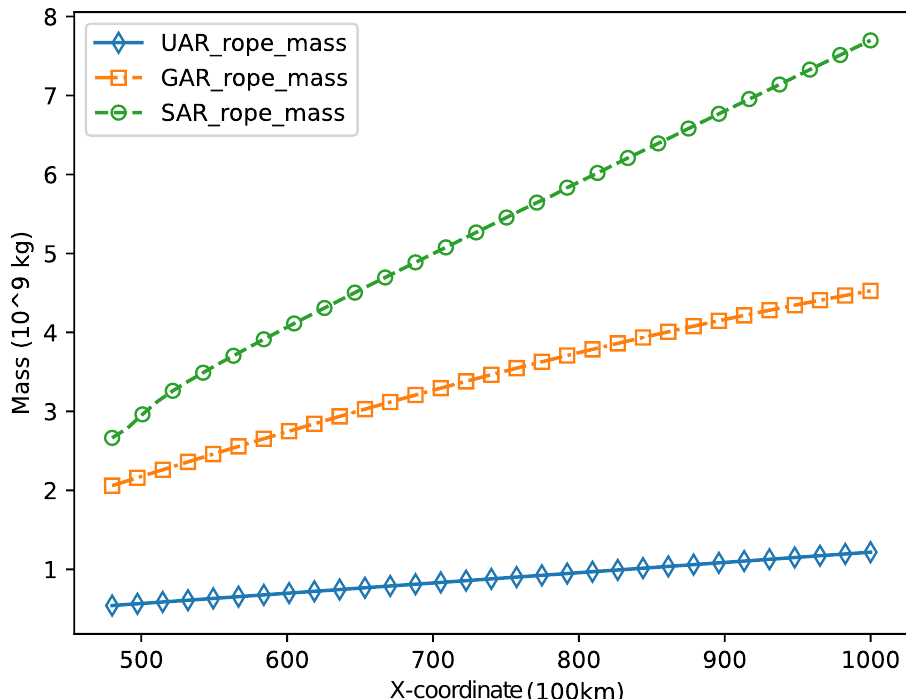
Figure 13. Rope mass and rope length curve of three space elevator systems.